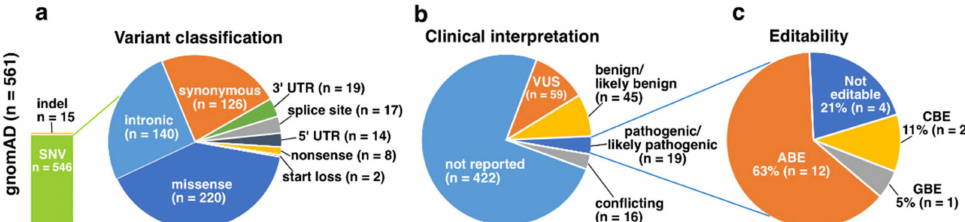
Figure 4. Graphical illustration of the gnomAD dataset. ( a ) Altogether 561 unique RHO variants have been reported in gnomAD, with 97% of them SNVs. ( b ) Clinical interpretation was reported for only 25% of the variants, and 3.4% were labeled as pathogenic or likely pathogenic. ( c ) Of the pathogenic or likely pathogenic variants, 79% could be edited with ABE, CBE or